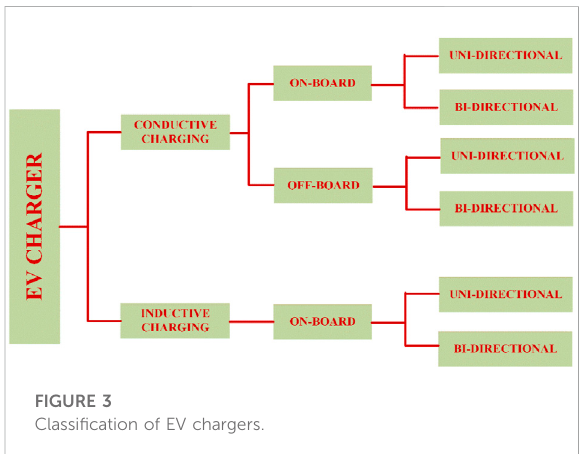
FIGURE 3 Classi fi cation of EV